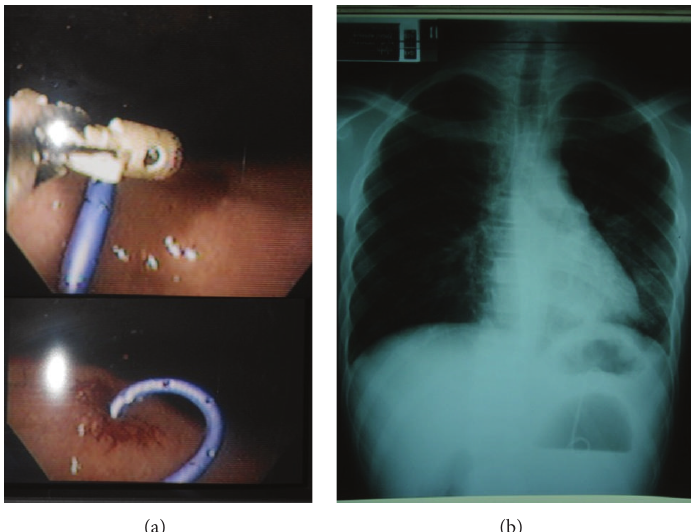
Figure 5: Placement of the end of the pigtail stent within the gastric lumen. Position confirmed on endoscopy (a) and on plan radiographs (b).